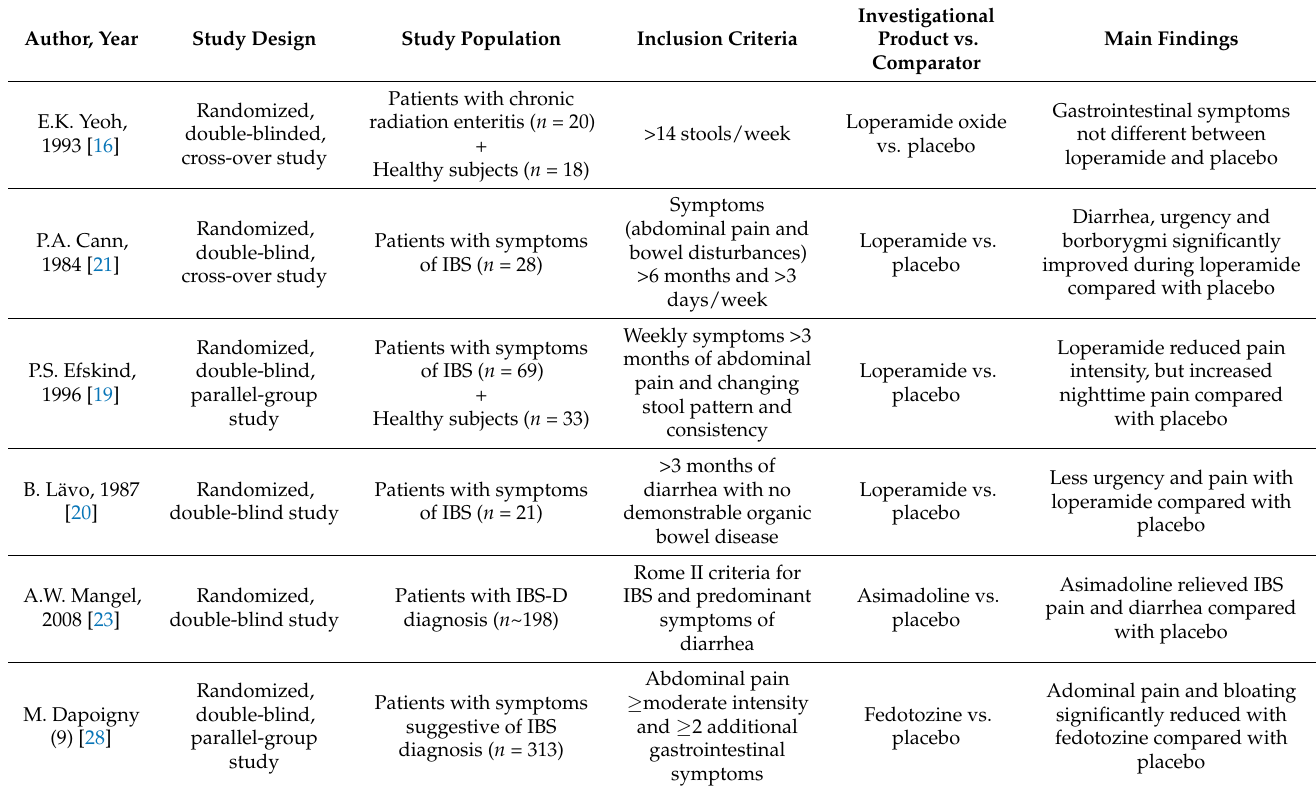
Table 4. Subjective impression of improvement